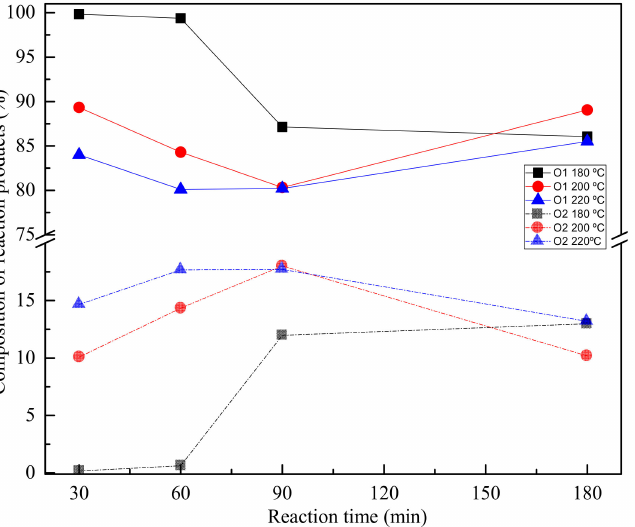
Figure 7. BHET monomer and dimer fraction values of reaction compounds at different reaction temperatures and times, as calculated by